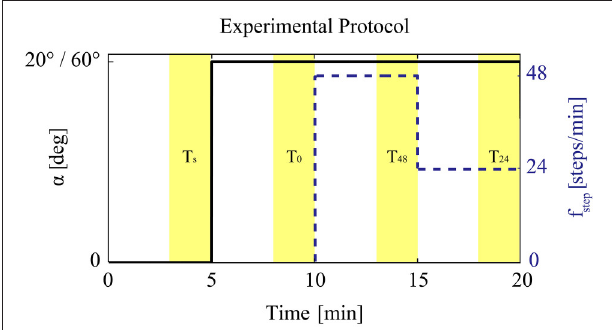
FIGURE 2 | Experimental protocol: After 5 min in the supine position, the subject was either tilted to α = 20 ◦ or α = 60 ◦ in a random order. During the head-up tilt, PE with 0, 24, and 48 steps per min was performed. The order of performing various leg exercise frequencies at each angle was